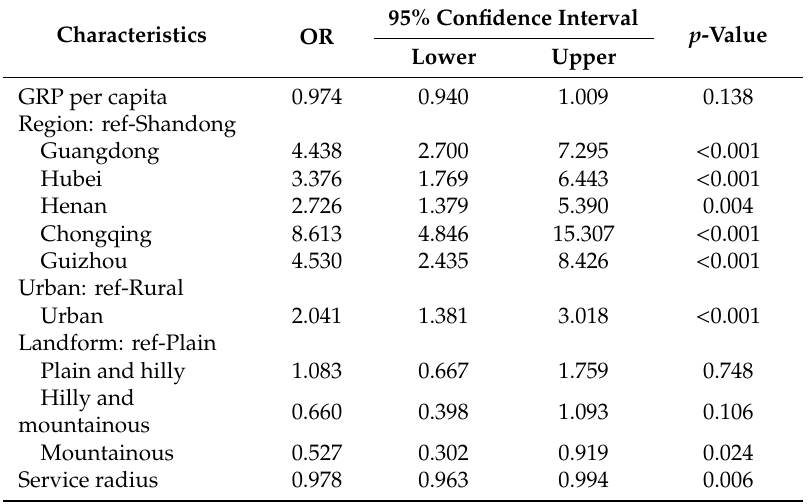
Table 5. Characteristics associated with different trajectories of basic clinical care ( n = 589).